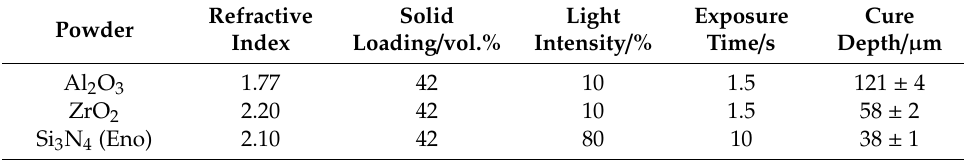
Table 3. The influence of powder type with different refractive index on slurry curing ability.